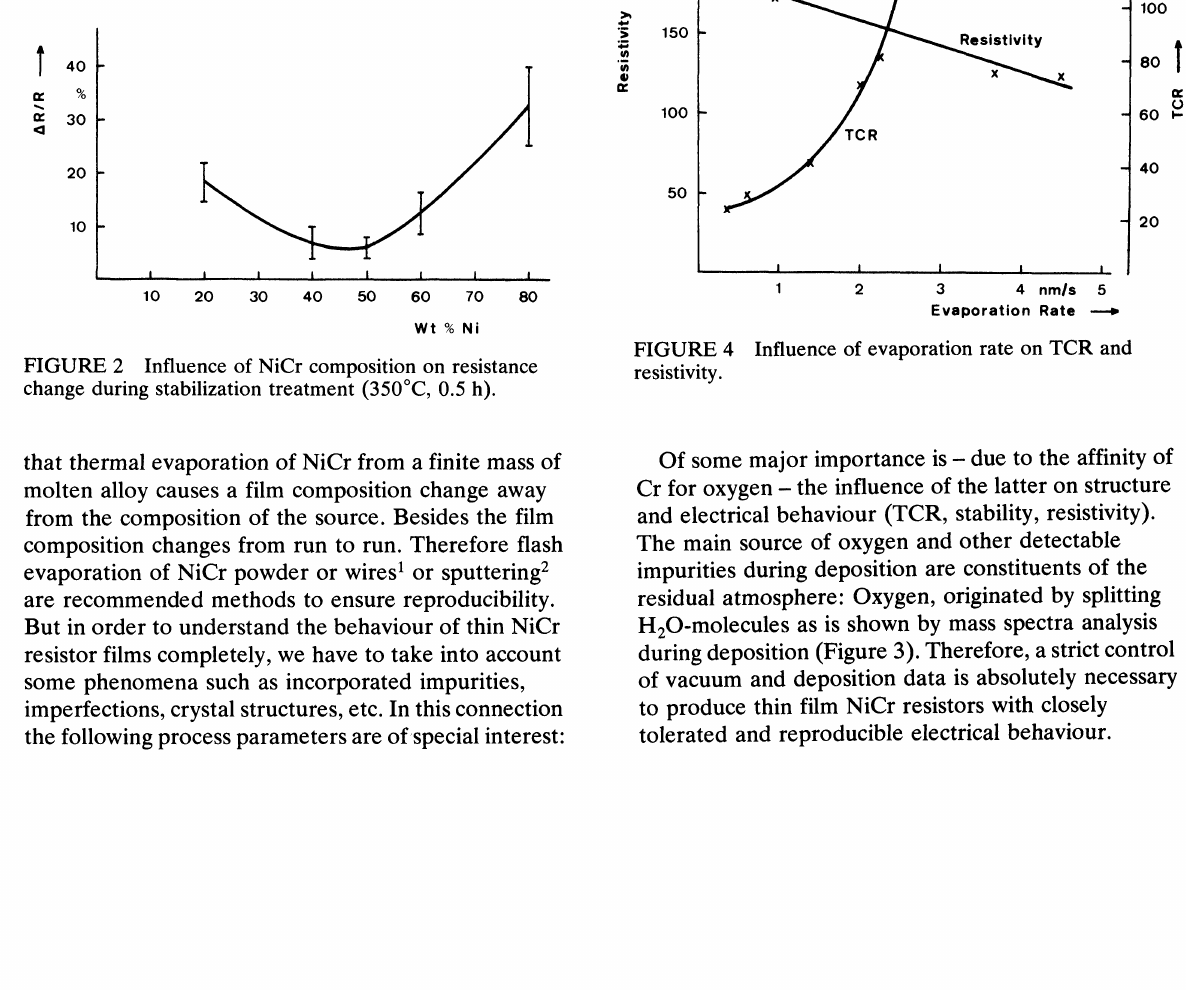
FIGURE 1 Influence of NiCr composition on TCR.